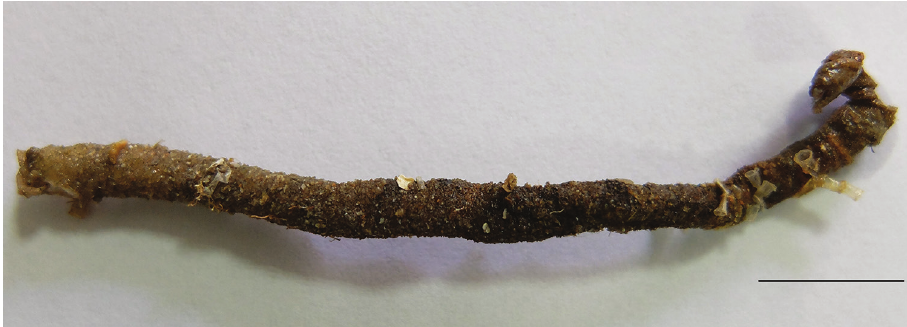
Figure 1. Phyllocomus chinensis sp. n., tube of holotype. Scale bar 2